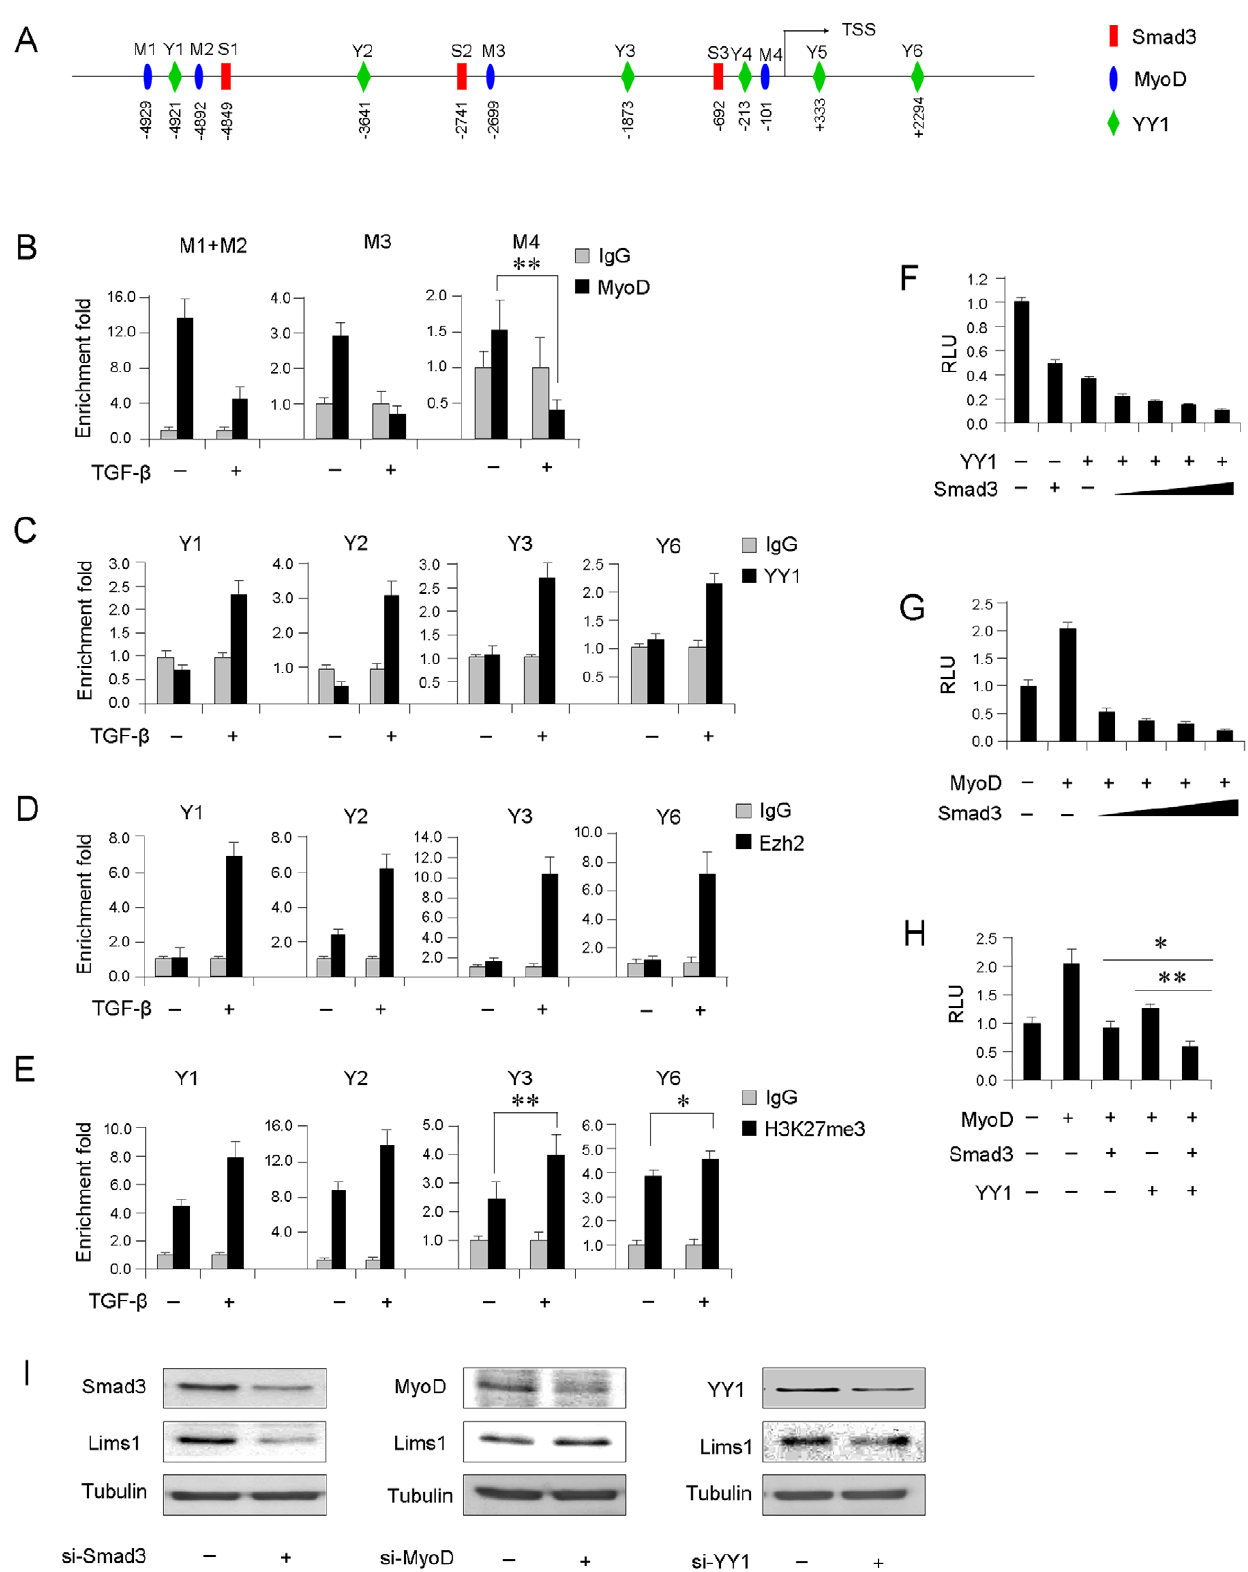
Figure 5. Smad3 suppresses miR-29 promoter through inhibiting MyoD binding and enhancing YY1 recruitment. (A) Schematic illustration of proximal promoter region of mmu-miR-29b/c primary transcript. The arrow denotes the Transcriptional Start Site (TSS). Predicted Smad3 (S), MyoD (M) and YY1 (Y) binding sites were displayed. The location of each site was indicated below. (B) C2C12 myoblasts were untreated or treated with TGF- b for 12 hrs at which time chromatins were collected for ChIP assays using antibodies against MyoD or IgG as controls. PCR assays